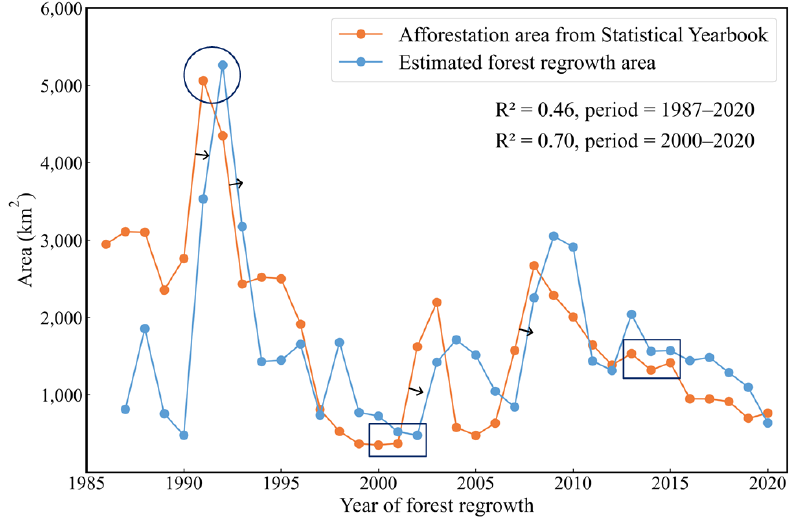
Figure 6. Comparison of the statistical afforestation area and estimated forest regrowth area.